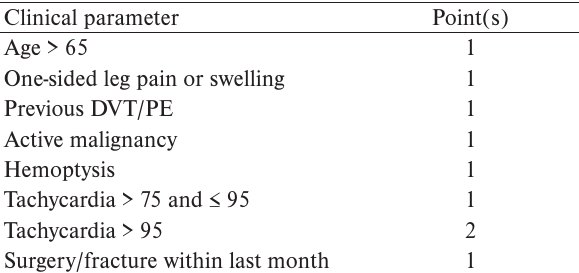
Table 1. Simplified revised Geneva Score clinical parameters overview.